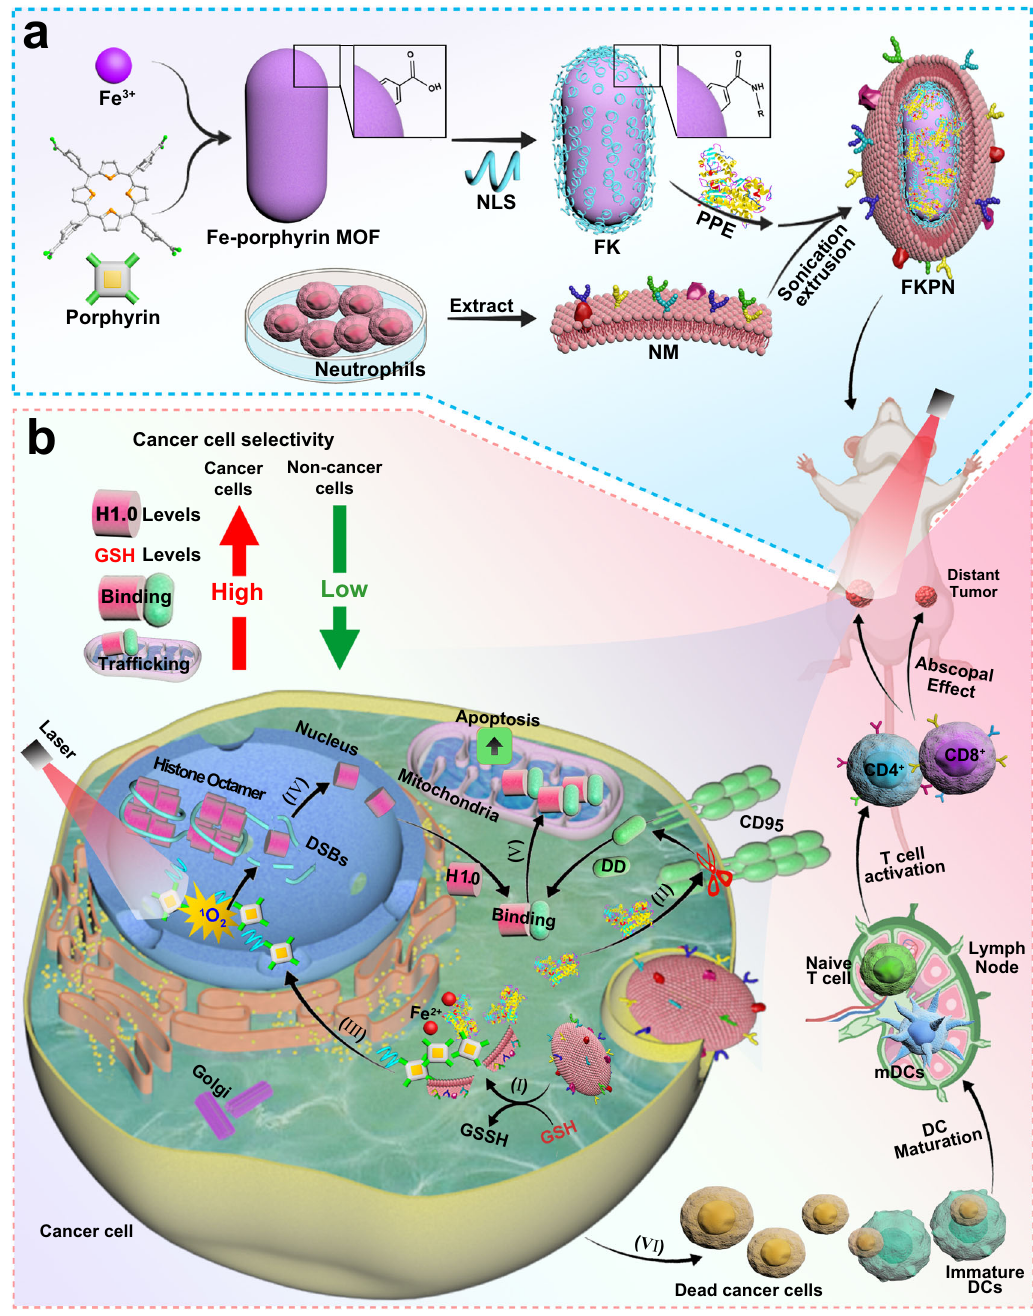
Fig. 1 | Tumor-speci fi c ampli fi cation of histone H1 translocation by FKPN mediates precision tumor discrimination and cancer immunotherapy. a Schematic illustration of preparation of biomimetic nanodevice FKPN. b BiologicalmechanismofFKPNforselectivecancercellkillingandimmunesystem activation throughPPEand tumor-speci fi c nuclear 1 O 2 generator:(I) GSH-triggered FKPN unlocking on porphyrin-NLS and PPE release; (II) PPE-mediated proteolytic liberation of CD95 DD; (III) nuclear transport and photodynamic effect of por- phyrin-NLS; (IV) Ampli fi ed histone H1 isoform release through nuclear 1 O